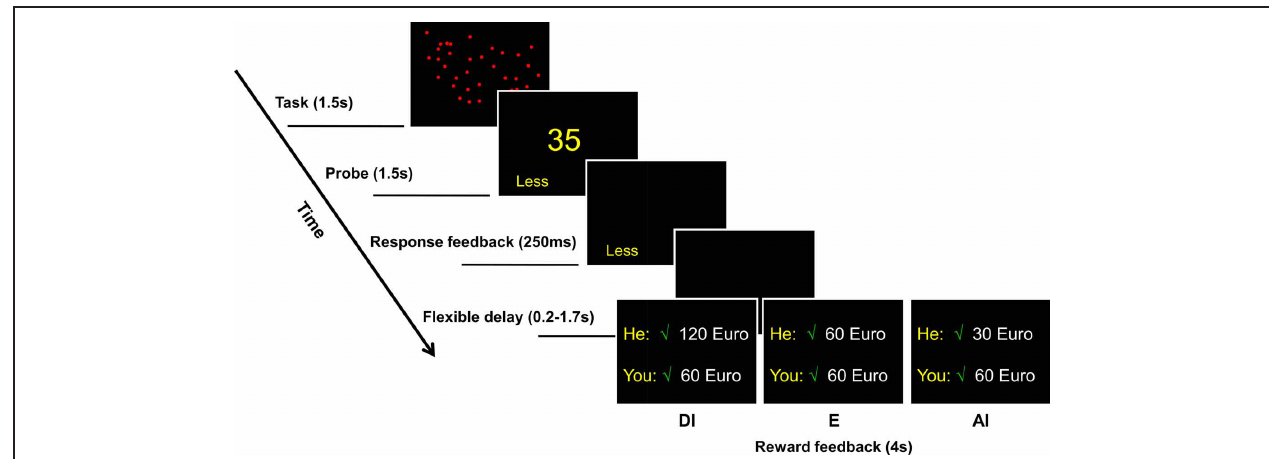
FIGURE 1 | Single-trial settings. Subjects saw a number of blue dots for 1500ms (screen 1). Immediately afterwards, a number was presented and subjects had to decide by pressing a button whether the number of dots on the first screen was less than or greater than this number within a time limit of 1500ms (screen 2). After a response feedback (250ms, screen 3) and a